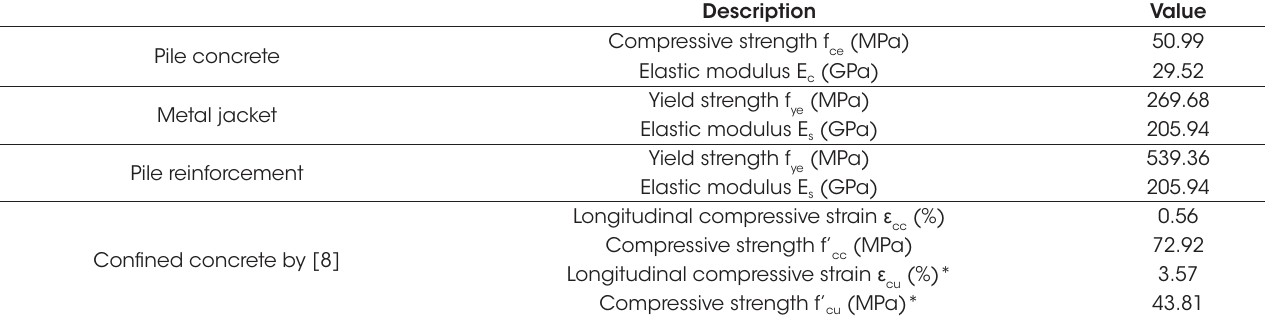
Properties of the plastic